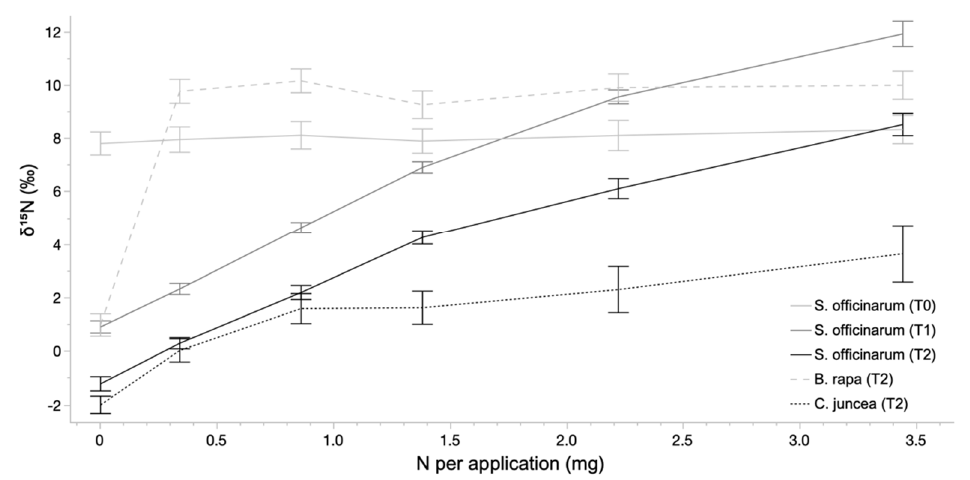
Figure 2. Values of δ 15 N across nitrogen application rates per plant per fertilization period for sugarcane and control plants. Sugarcane ( S. officinarum ) is represented at initiation (T0), Harvest 1 (T1), and Harvest 2 (T2), while control plants ( B. rapa and C. juncea ) were only grown and measured during Harvest 2 (T2). Lines represent mean values and error bars represent the 95% confidence interval of the mean.